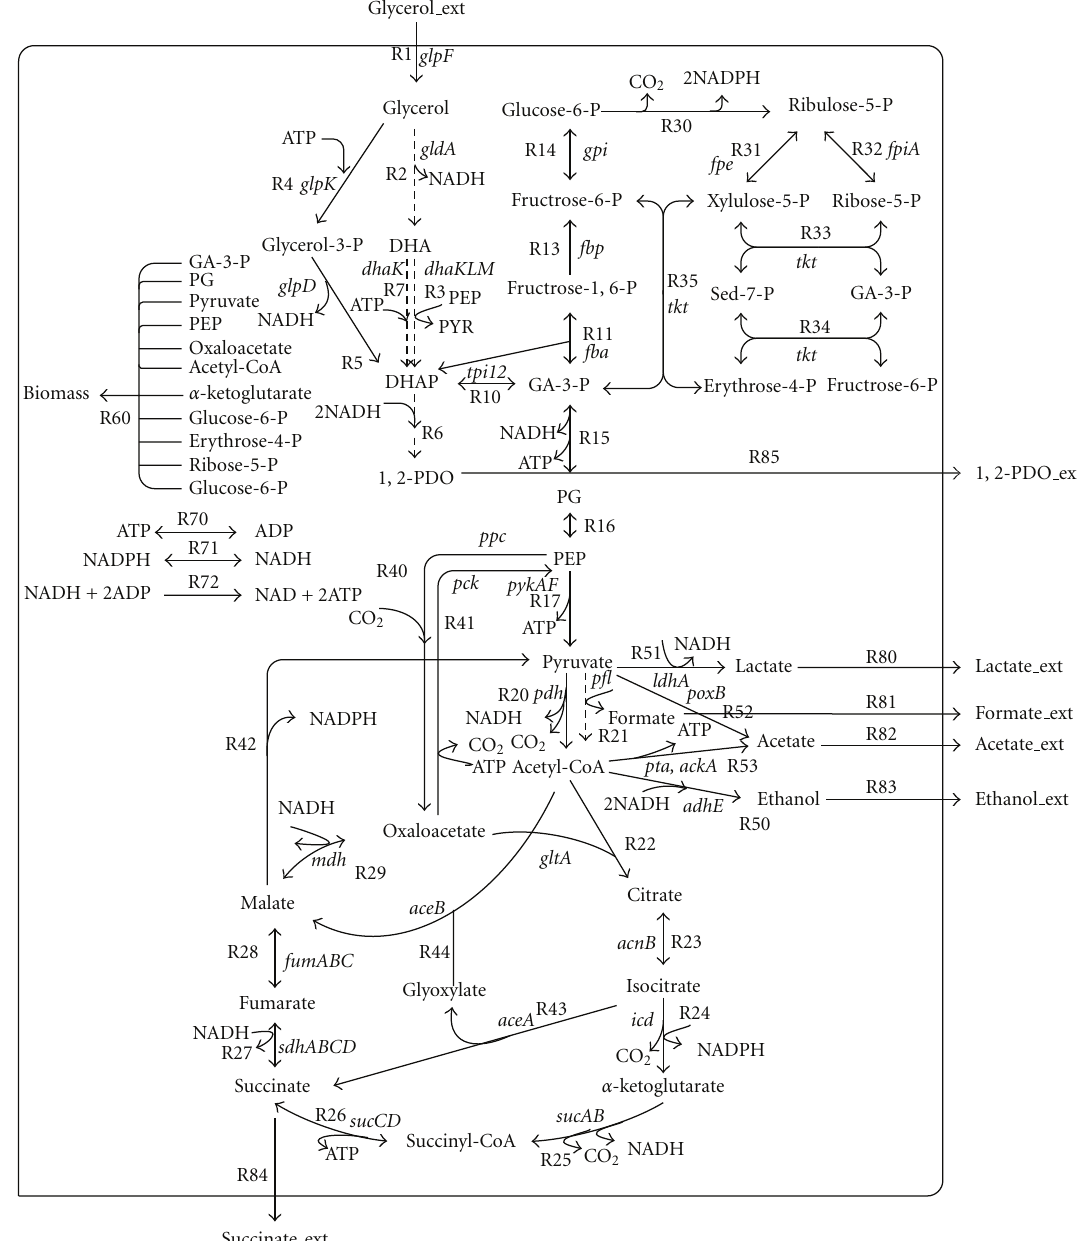
Figure 1: Central metabolic network of glycerol in wildtype E. coli . The dashed arrows represent the particular pathways in anaerobic conditions. Reversible reactions are represented by a double-headed arrow. Key genes associated with the pathway are included.